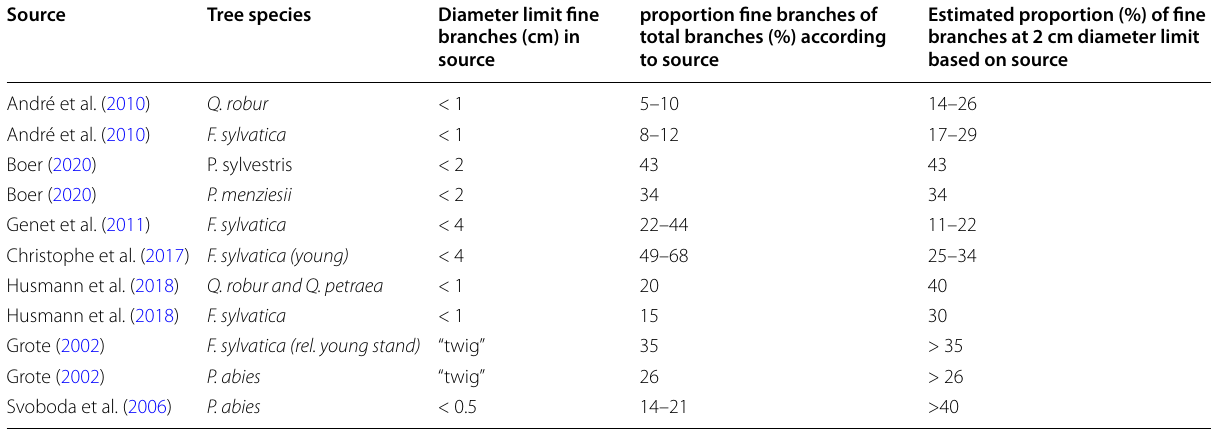
Table 11 Mass proportions for fine branch wood of total branch wood per tree species using the diameter limit for fine branches given in the source, and estimated proportion using a 2-cm limit. Twig refers to leave carrying parts of